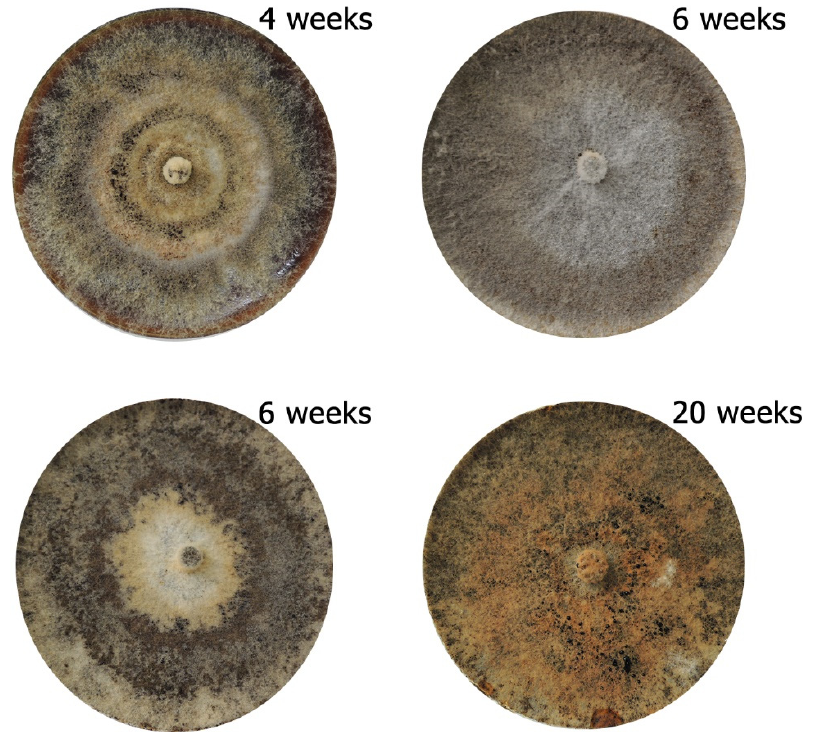
Figure 3. Variation in color of Cryptostroma corticale isolate ZLVG 859 on potato dextrose agar.